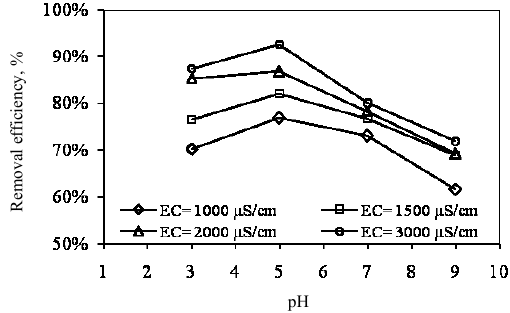
Figure 3. Effect of pH on the removal efficiency of HA (initial concentration of HA: 20 mg L -1 , applied voltage: 50 V and reaction time: 75